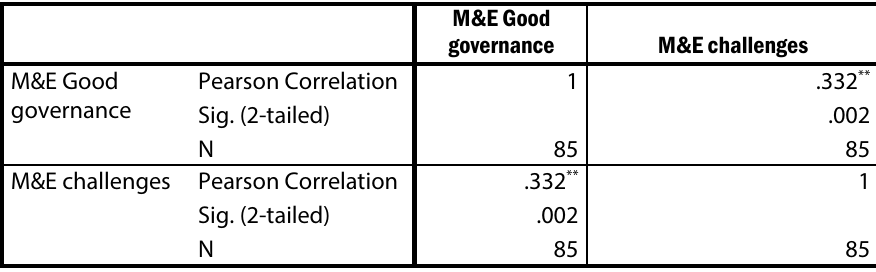
Table 10: Correlation between Good Governance and Challenges in implementation Correlations